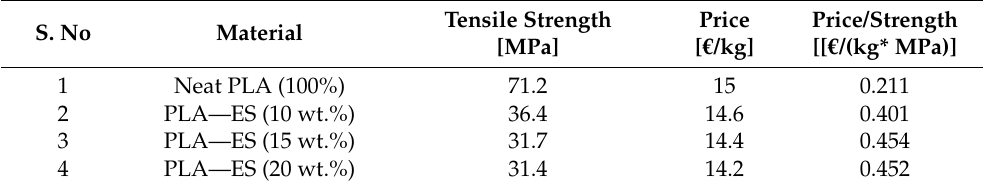
Table 3. Cost analysis of PLA filled with eggshell powder.